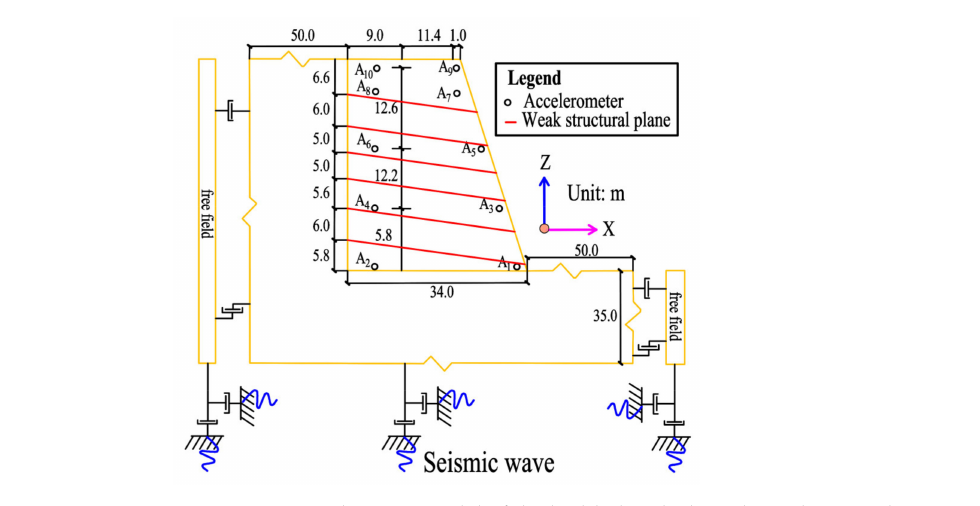
Figure 3. Generalization model of the bedded rock slope, boundary condition setting, and layout of the monitoring points in the model.